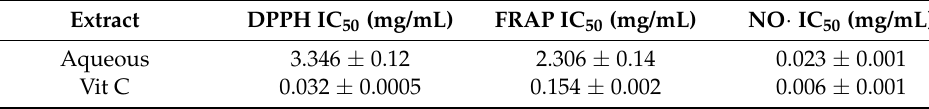
Table 3. The antioxidant activity of Cleome fruits extract.